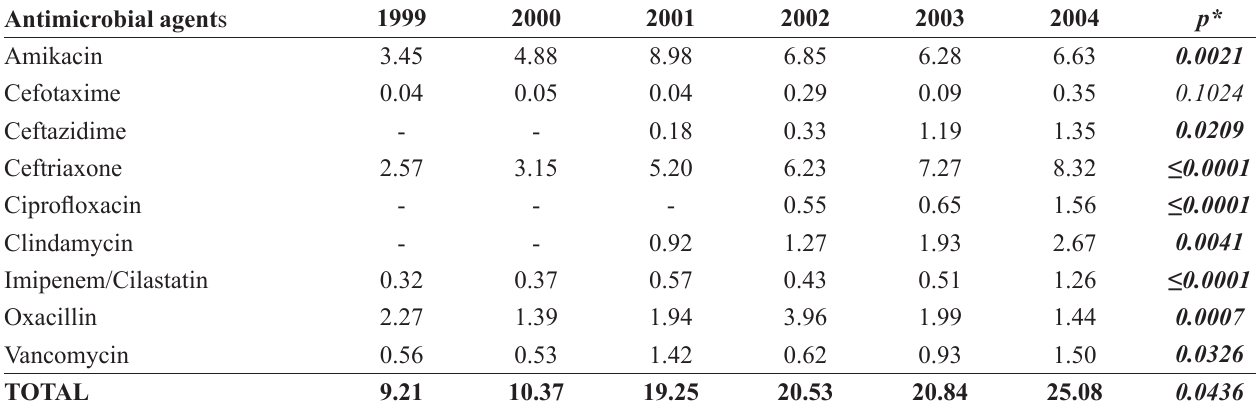
* ANOVA: comparison of monthly averages of consumption, expressed in DDD/100 patients-day, for every analyzed antimicrobial agents and year.